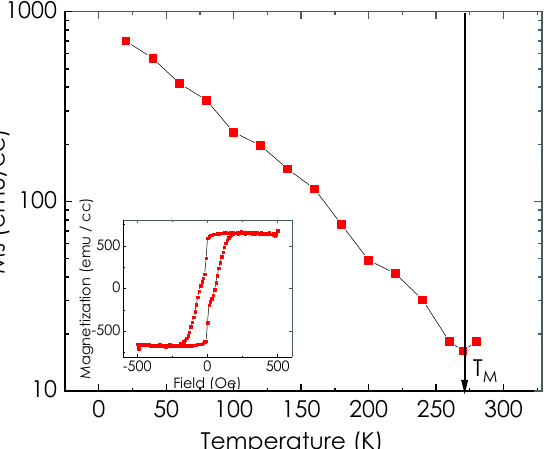
Figure 4. M-T curve of GdIG 10 nm thin film post-annealed at 750 °C. Inset shows the M-H curve at 20 K. Table 2. Compensation temperature T M and saturation magnetization ( M s) at 20 K of GdIG . Source